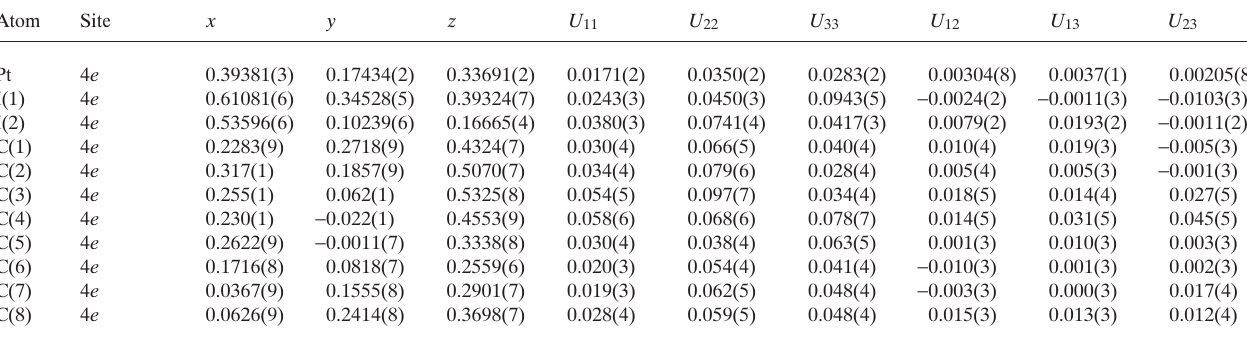
Table 6. Atomic coordinates and displacement parameters (in Å 2 )